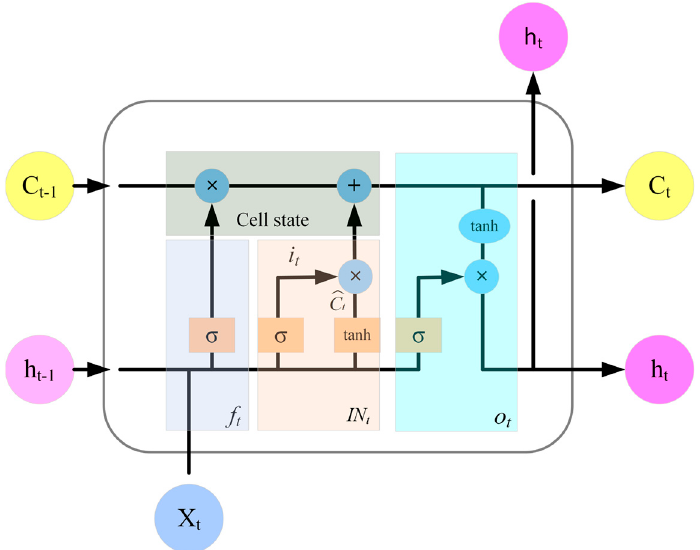
Figure 2. The basic structure of Long-Short Term Memory (LSTM) at time step t. f t , forget gate; IN t , input gate; O t , output gate, and cell state. The C t value represents the cell state at time step t; C t − 1 value represents the cell state at time step t − 1; X t , current inputs; h t , output result of hidden layer at time step t; h t − 1 , output result of hidden layer at time step t − 1; σ , sigmoid activation function; tanh, hyperbolic tangent function.